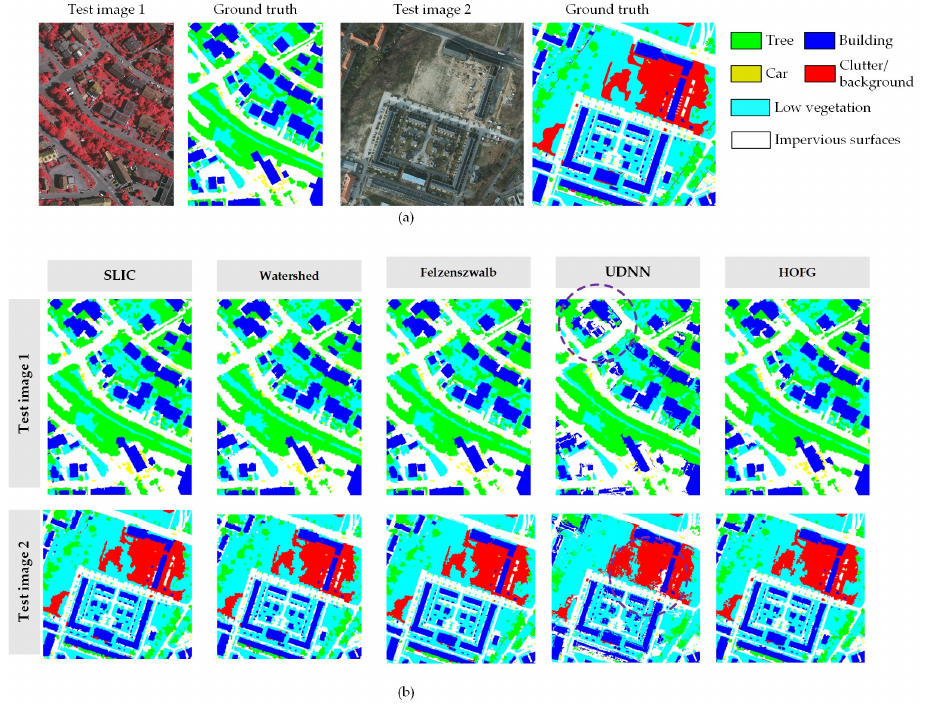
Figure 9. Test images and segmentation quality evaluation results: ( a ) test images and ground truth; ( b ) segmentation results with category labels.